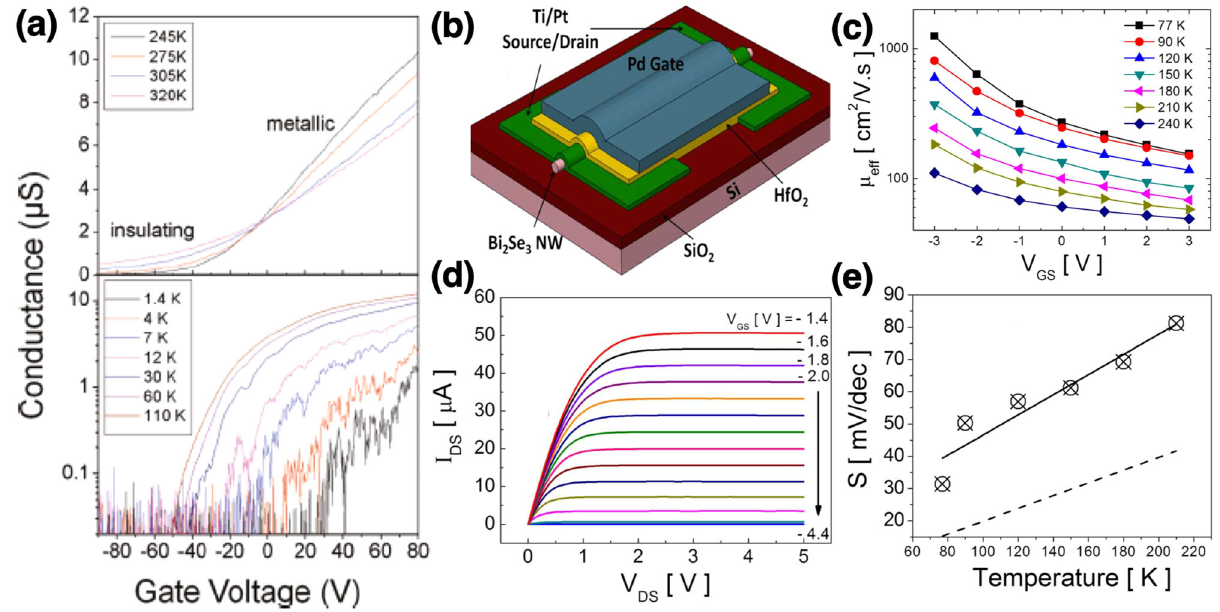
Fig. 1 Topological transistors. a Experimental measurements of the conductance versus the applied gate voltage showing metallic and insulating behavior of ultra-thin 3D topological insulator Bi 2 Se 3 FETs at a variety of different temperatures. Reprinted (adapted) with permission from ref. 24 , copyright 2011. b Schematic illustration of the design of a gate-all-around (GAA) design of a nanowire FET fabricated in Bi 2 Se 3 29 . c The thermal evolution of the experimentally extracted effective mobility within the channel of the Bi 2 Se 3 nanowire FET as a function of the applied gate voltage 29 . We immediately notice that the mobility is far less than typical semiconductors currently used in CMOS devices. d The drain terminal current, I DS , plotted against the applied drain voltage, V DS , at T sys = 77 K demonstrating that typical transistor transfer curves may be obtained in topological FETs 29 . e The sub-threshold slope as extracted from nanowire topological FETs (solid line) showing that the incarnation of the topological FET requires more energy to switch from the “ off ” state to the “ on ” state than an ideal FET. Reprinted by permission from ref. 29 , copyright